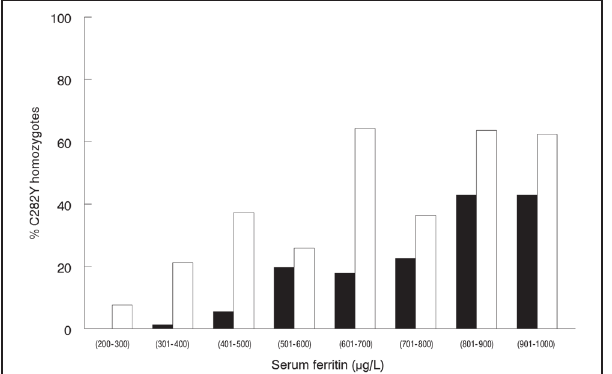
Figure 1) The proportion of male (black bars [n=378]) and female (open bars [n=272]) participants with an elevated ferritin level and transferrin sat- uration who were C282Y homozygotes. Reproduced with permission from reference